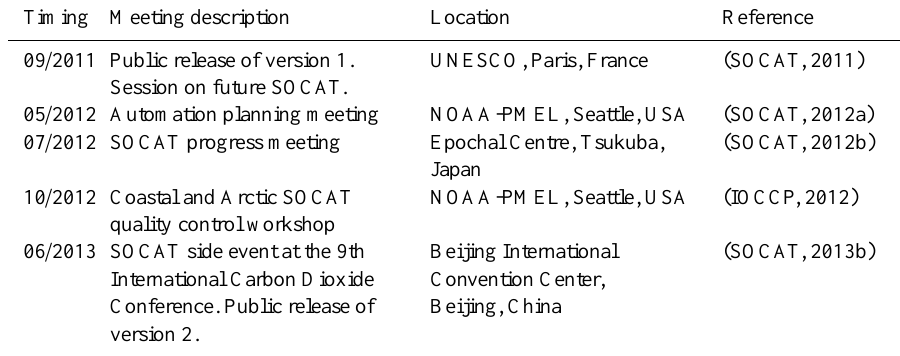
Table 6. Meetings for SOCAT versions 2 and 3 to date. Timing Meeting